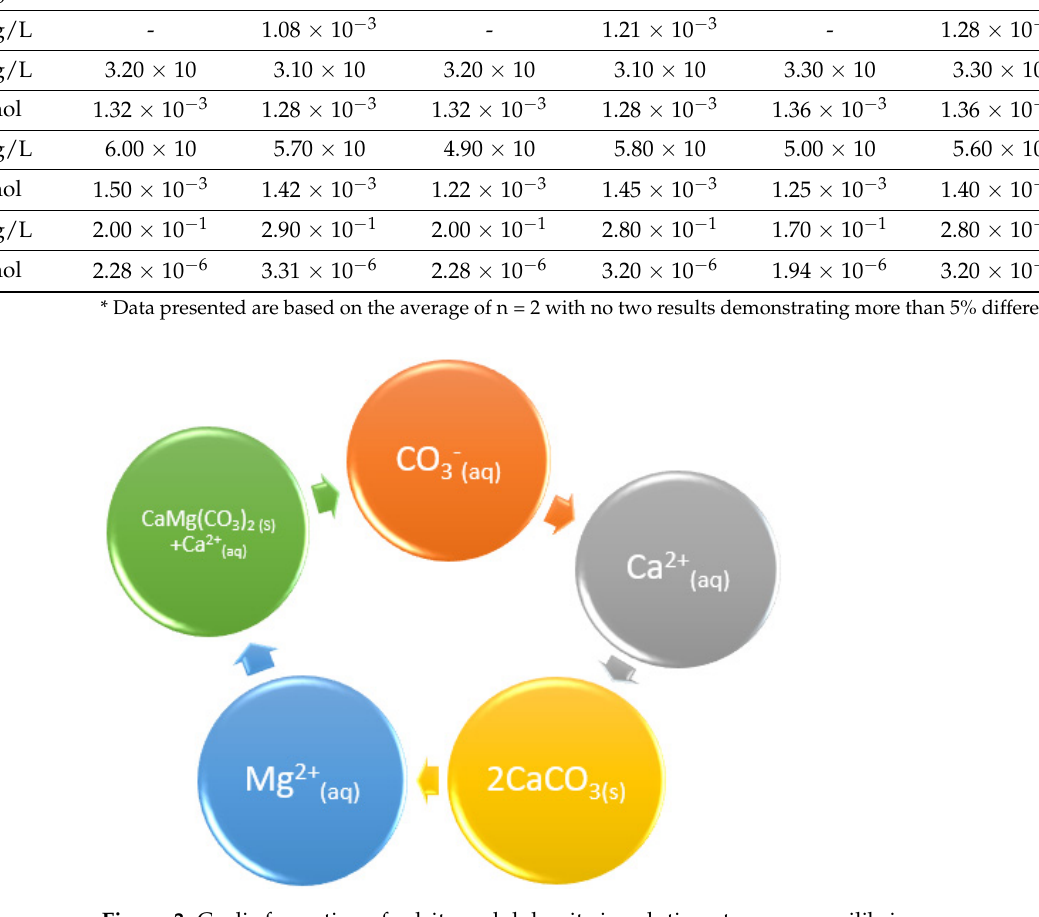
Figure 3. Cyclic formation of calcite and dolomite in solution at or near equilibrium.